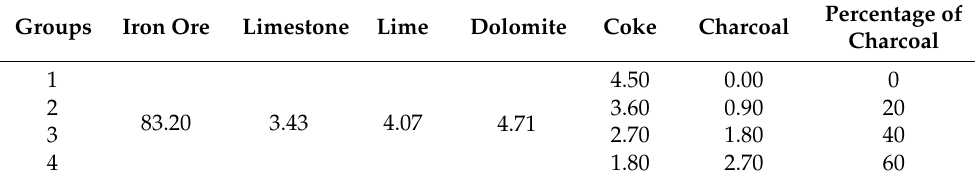
Table 3. The sintering experiment scheme (mass